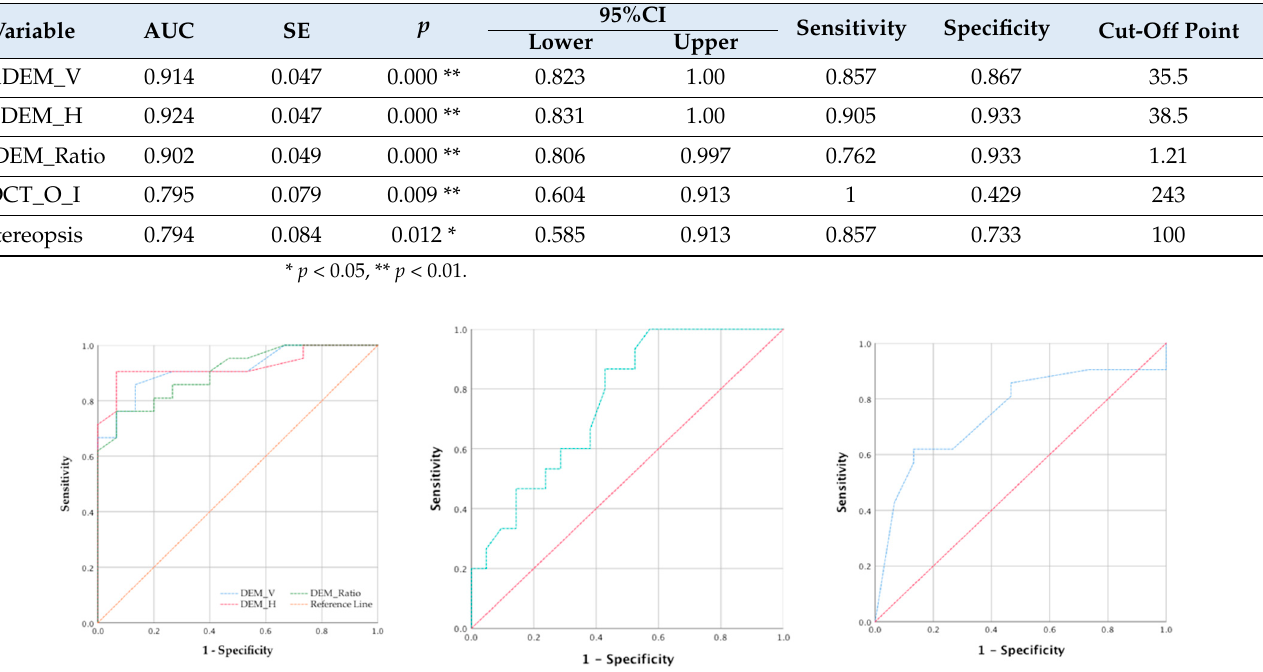
Table 5. ROC curve analysis about DEM, stereopsis, and OCT.